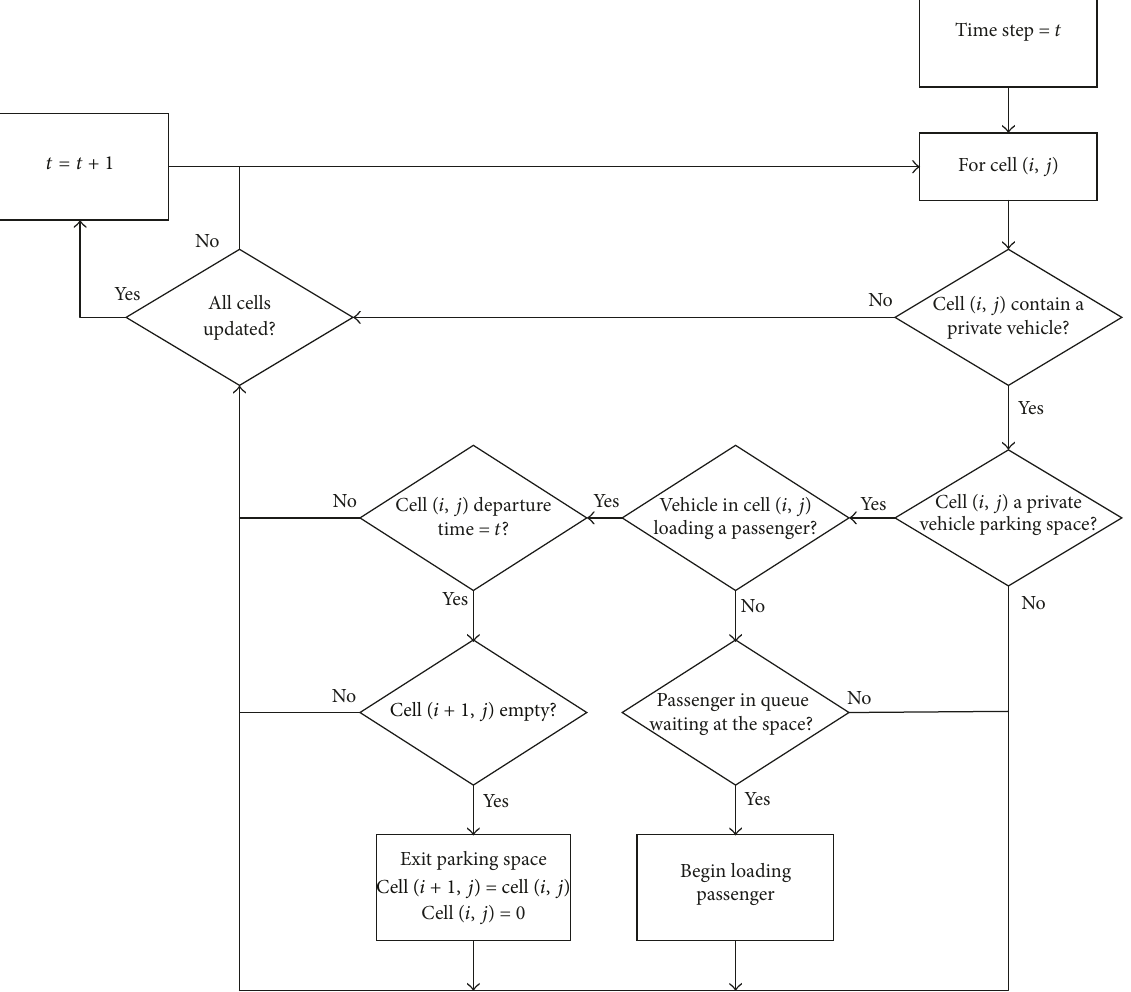
Figure 6: Algorithm for private vehicles exiting a parking